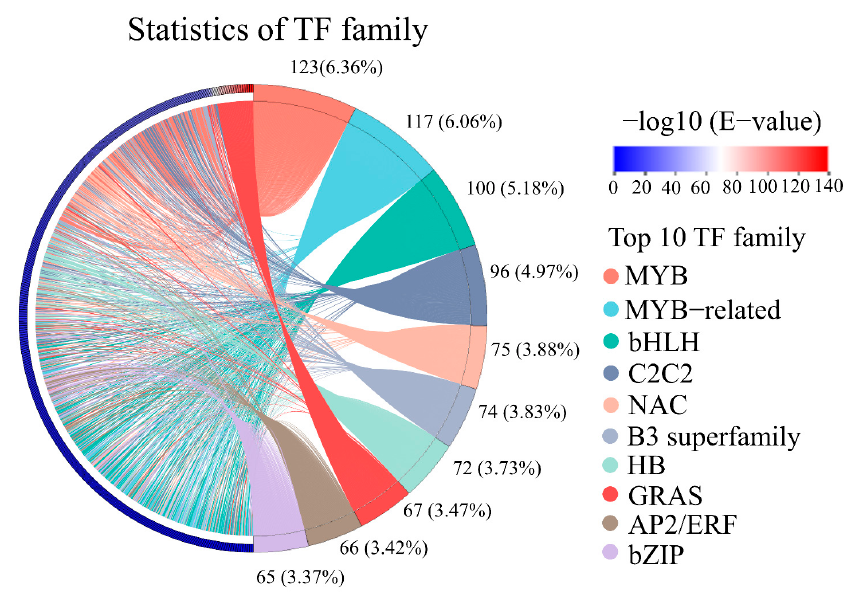
Figure 6. Transcription factors (TFs) in in E. ulmoides leaves.